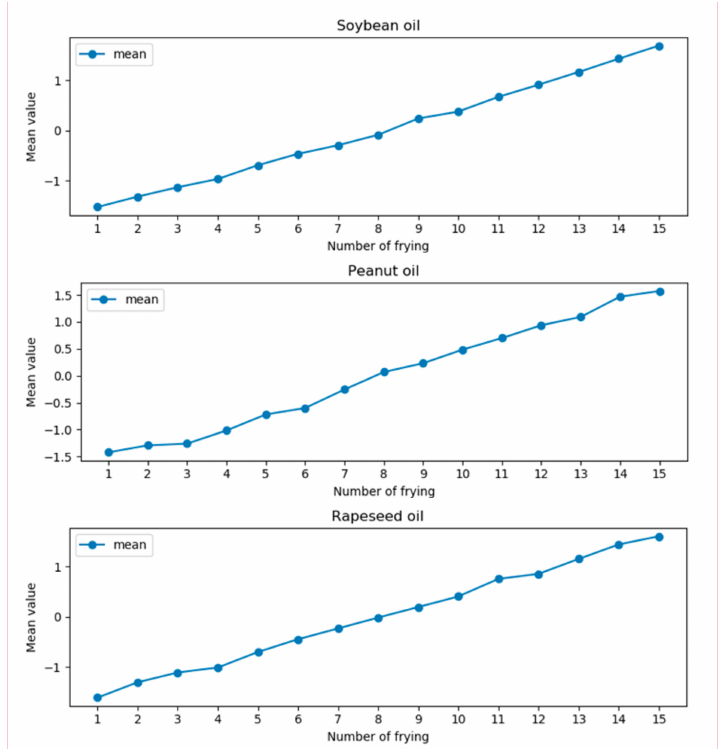
Figure 6. The mean curves of the three types of oils are calculated by the Z-score.